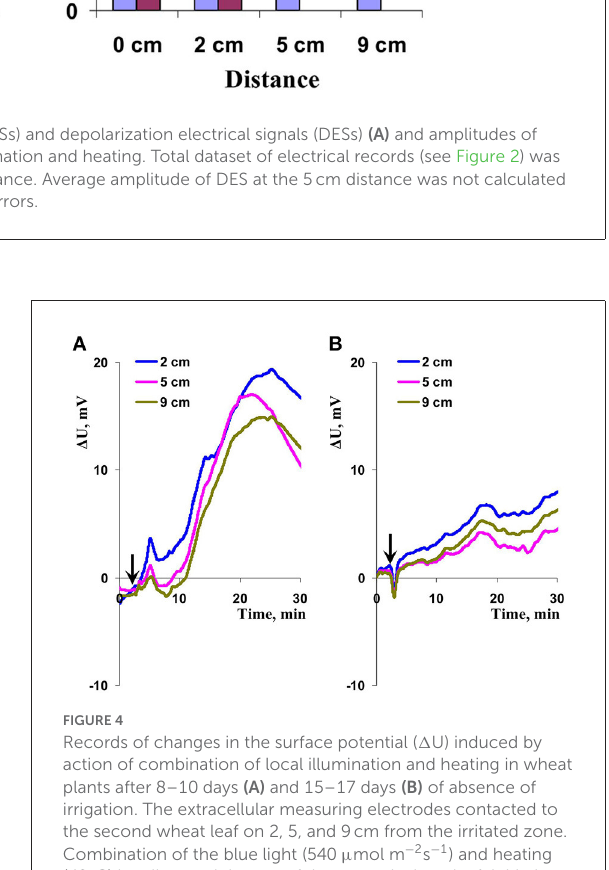
drought should influence plant signaling. It was